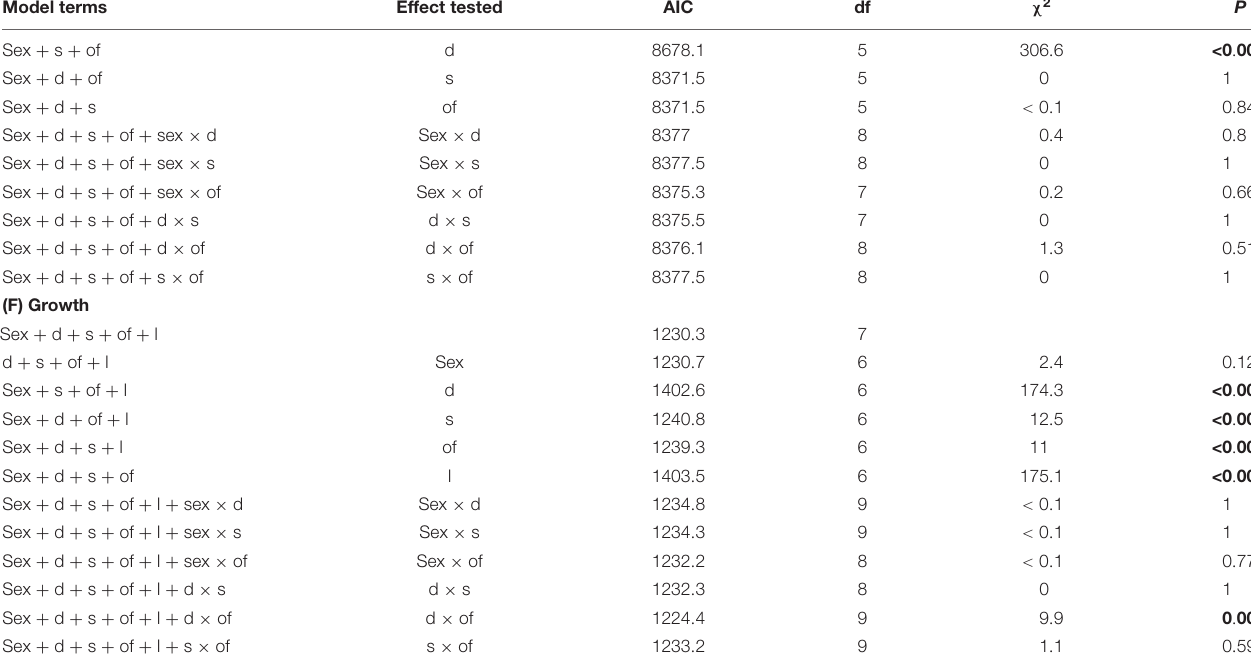
Frontiers in Ecology and Evolution |